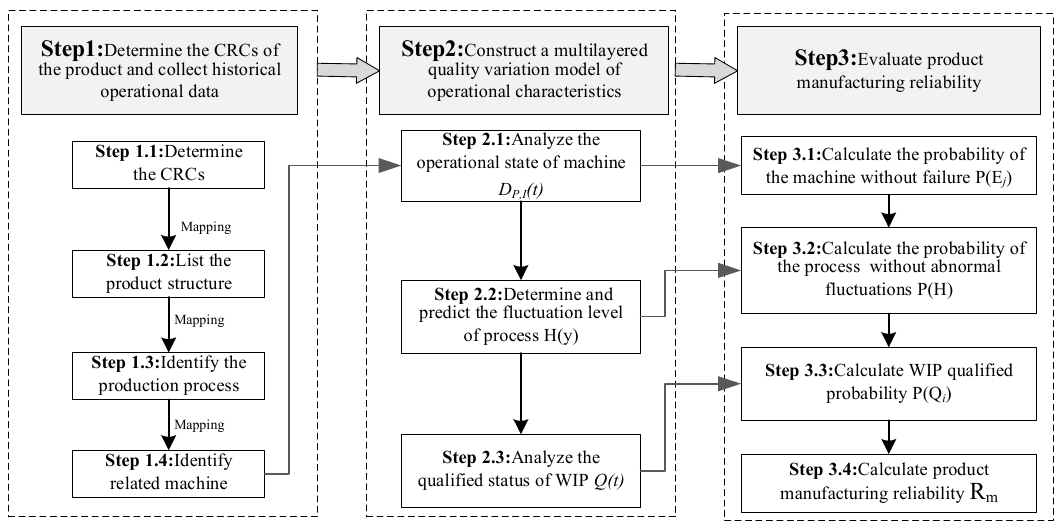
Figure 5. Workflow of the product manufacturing reliability modeling.